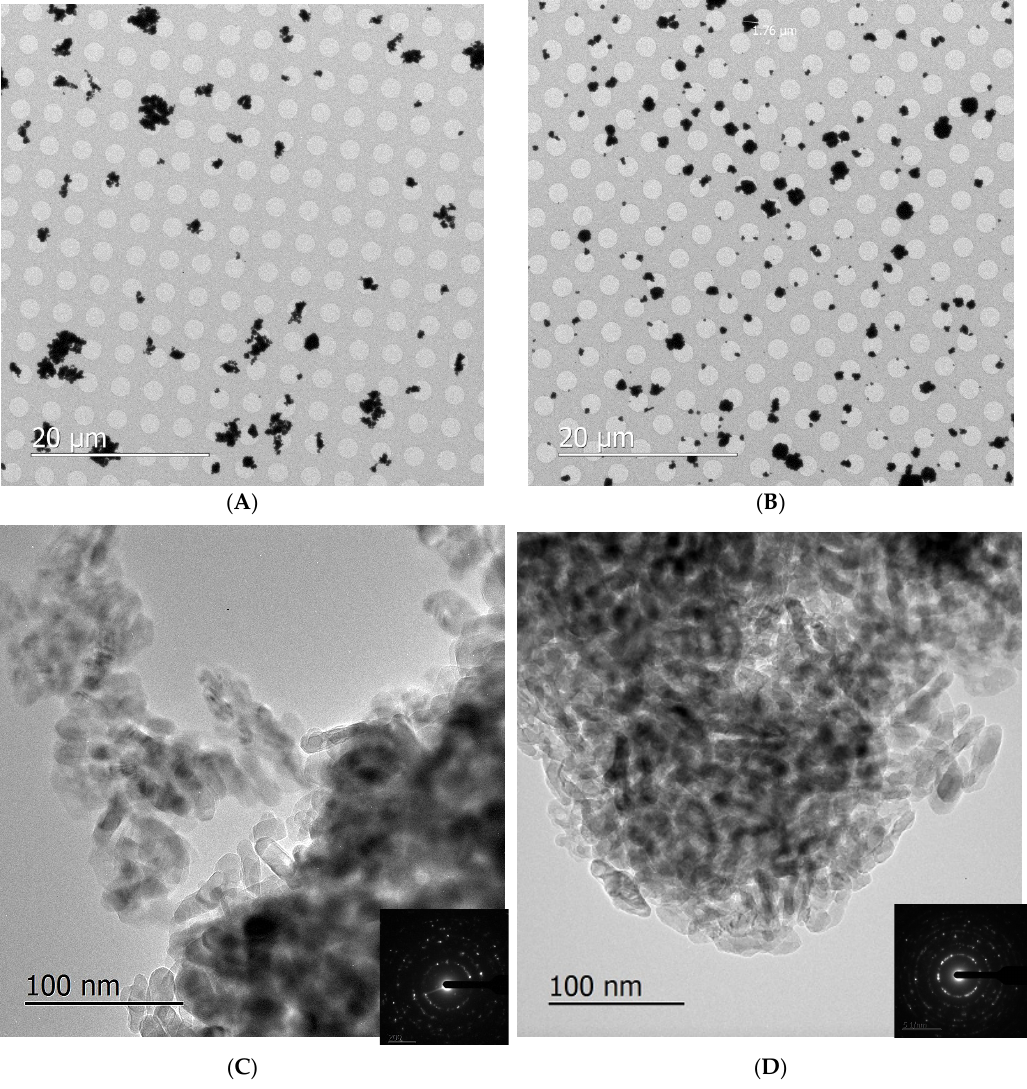
Figure 9. TEM images of NPs dispersed in the aerosol with the dust jet generator ( A , C ) and the collision jet generator ( B , D ) and collected on grids. The inset represents the corresponding selected area electron diffraction patterns confirming the nano ‐ crystalline anatase TiO 2 structure.